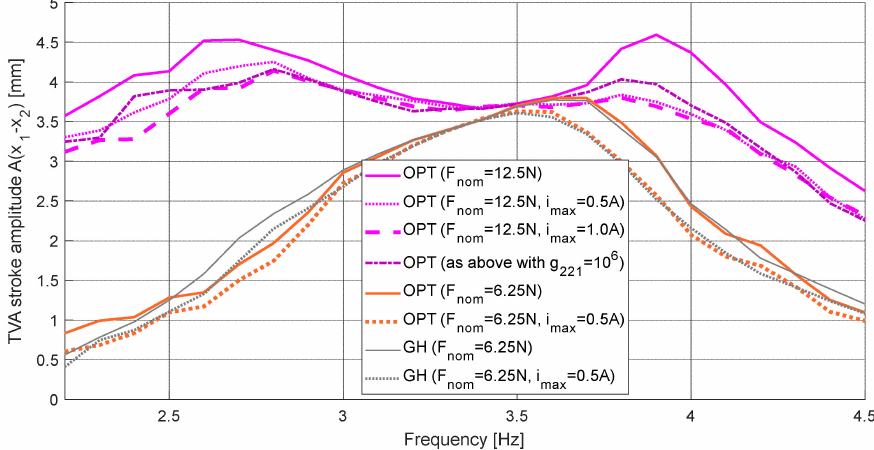
Figure 10. The TVA stroke amplitude A ( x 1 − x 2 ) frequency characteristics: OPT for different control parameter values vs. GH for F nom = 6.25